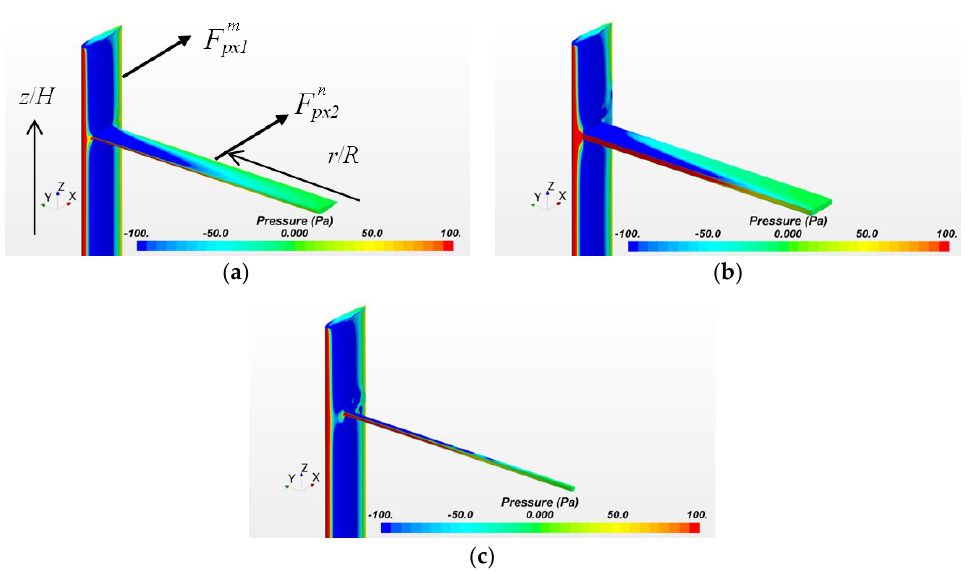
Figure 11. Surface pressure distributions on a blade and an arm in each rotor case with different cross-section arms: ( a ) airfoil arm rotor, ( b ) rectangular arm rotor, and ( c ) circular arm rotor.